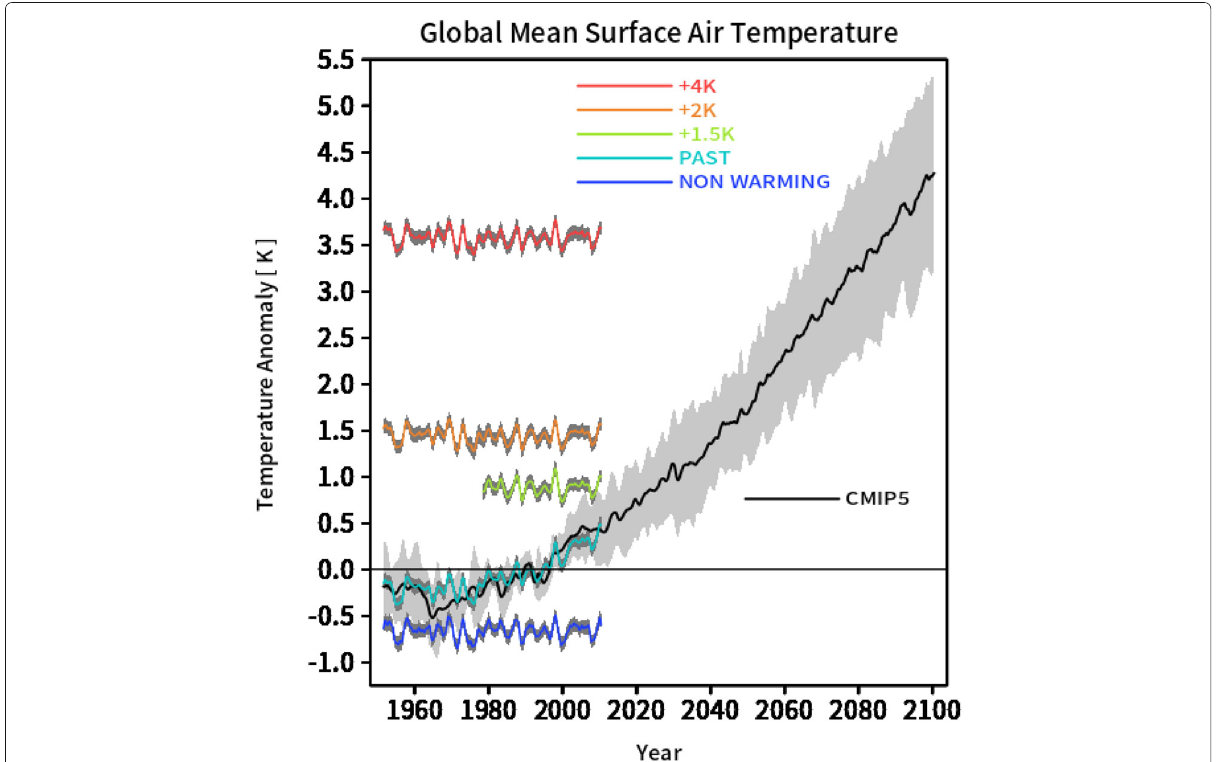
Fig. 3 Time series of global mean surface air temperature anomalies of d4PDF-G for past (light blue), nonwaming (blue), +1.5 K (green), +2 K (orange), and +4 K (red) climate simulations and CMIP5 historical and RCP8.5 experiments with six climate models. Shading indicates two-sigma uncertainties. Time series are drawn relative to the averages for the period from 1975 to 2005